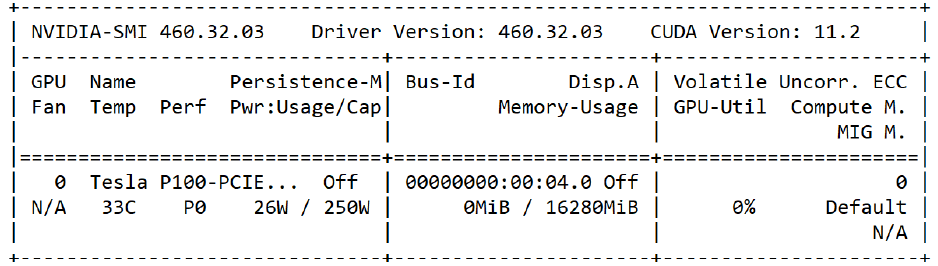
Figure 12. GPU technical specifications from Google Colab.